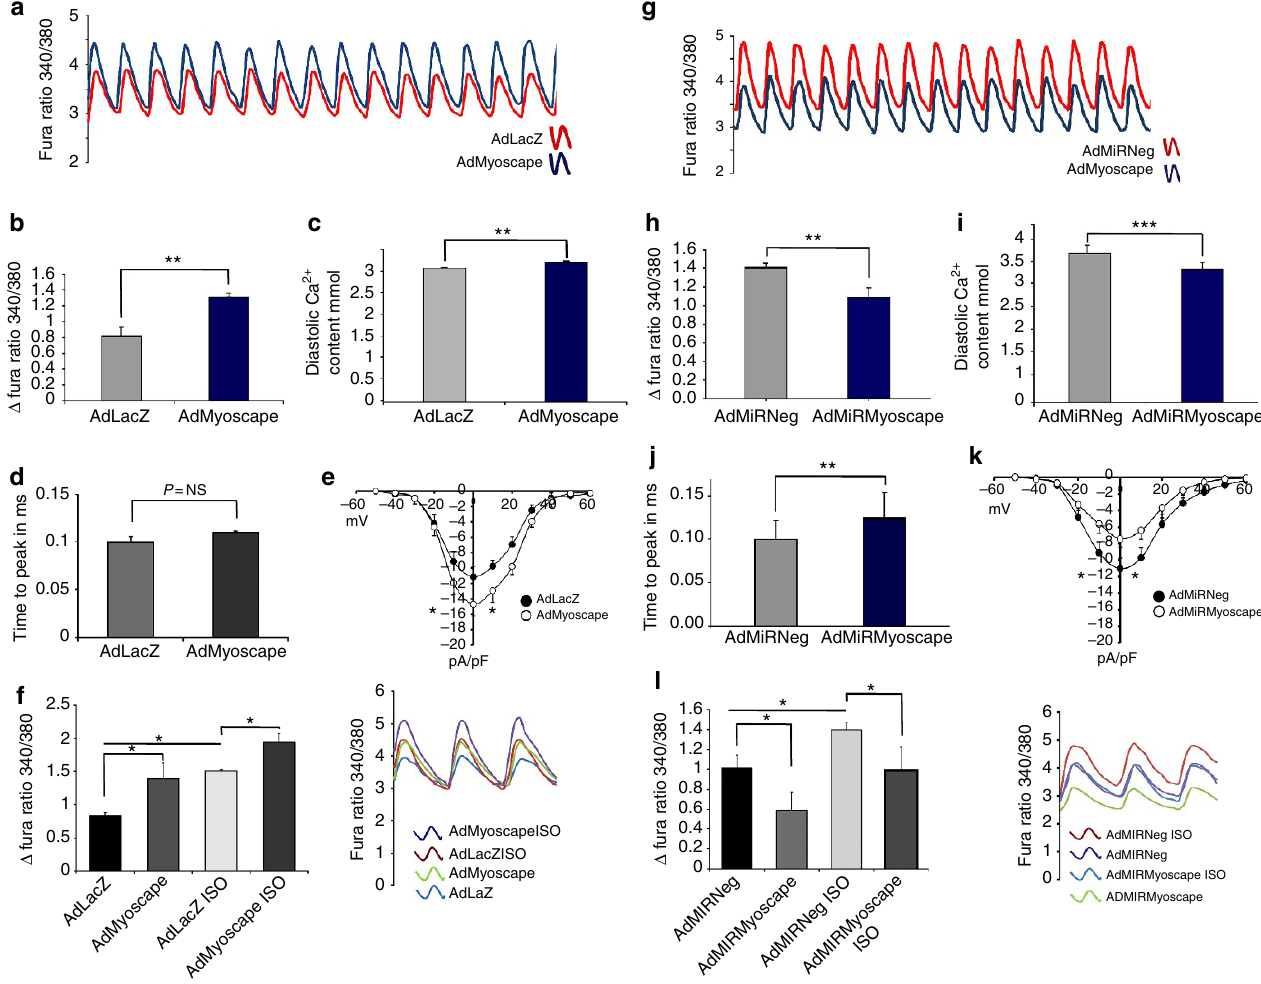
Figure 2 | Myoscape overexpression improves global calcium transients in ARVCM. ( a ) Representative recordings of calcium transients after infection with 20i.f.u. AdMyoscape and 20i.f.u. AdLacZ serving as a control, and pacing ARVCM with two hertz, showing significant improvement of calcium transients on Myoscape overexpression assessed by Fura-2 ratios. ( b ) Statistical evaluation of global calcium amplitude (total count of 135 cells, n ¼ 4 independent experiments, ** P o 0.001 (ANOVA)) and diastolic calcium content ( c ); total count of 130 cells, n ¼ 4, ** P o 0.01 (ANOVA)) in ARVCMs after adenoviral Myoscape overexpression. ( d ) Time to peak measurements of calcium transients after Myoscape overexpression were unaffected compared with AdLacZ infected cells. ( e ) Measurements of whole-cell L-type calcium currents in ARVCM’s after adenoviral Myoscape overexpression compared with LacZ-infected controls, (nine cells of two animals each; 20i.f.u.; * P o 0.05 (ANOVA)). ( f ) Statistical evaluation (left panel) and representative calcium transient recordings of ARVCMs (right panel) after overexpression of Myoscape in the presence or absence of simultaneous isoproterenol stimulation (100 m M). ( g ) Myoscape ablation impairs global calcium transients in ARVCM as shown by a representative recording of calcium transients assessed by Fura-2 ratios after infection of ARVCM with 100i.f.u. AdMiRMyoscape and 100 ifu AdMiRNeg as a control ( h ) Statistical evaluation of global calcium amplitude (total count of 120 cells, n ¼ 4, *** P o 0.001 (ANOVA)) and diastolic calcium content ( i ) in ARVCM after adenoviral Myoscape knockdown. ( j ) Statistical evaluation of the time to peak measurements in ARVCM (total count of 60 cells, n ¼ 3, 0.12 versus 0.09ms, ** P o 0.01 (ANOVA)). ( k ) Measurements of whole-cell L-type calcium currents after adenoviral Myoscape knockdown compared with AdMiRNeg-infected controls ( n ¼ 9cells of 2 animals each), revealing significant impairment of L-type channel function * P o 0.05). ( l ) Statistical evaluation (left panel) and representative calcium transient recordings of ARVCMs (right panel) after knockdown of Myoscape in the presence or absence of isoproterenol (100 m M) ( n ¼ 3) * P o 0.05 (ANOVA). NS, not